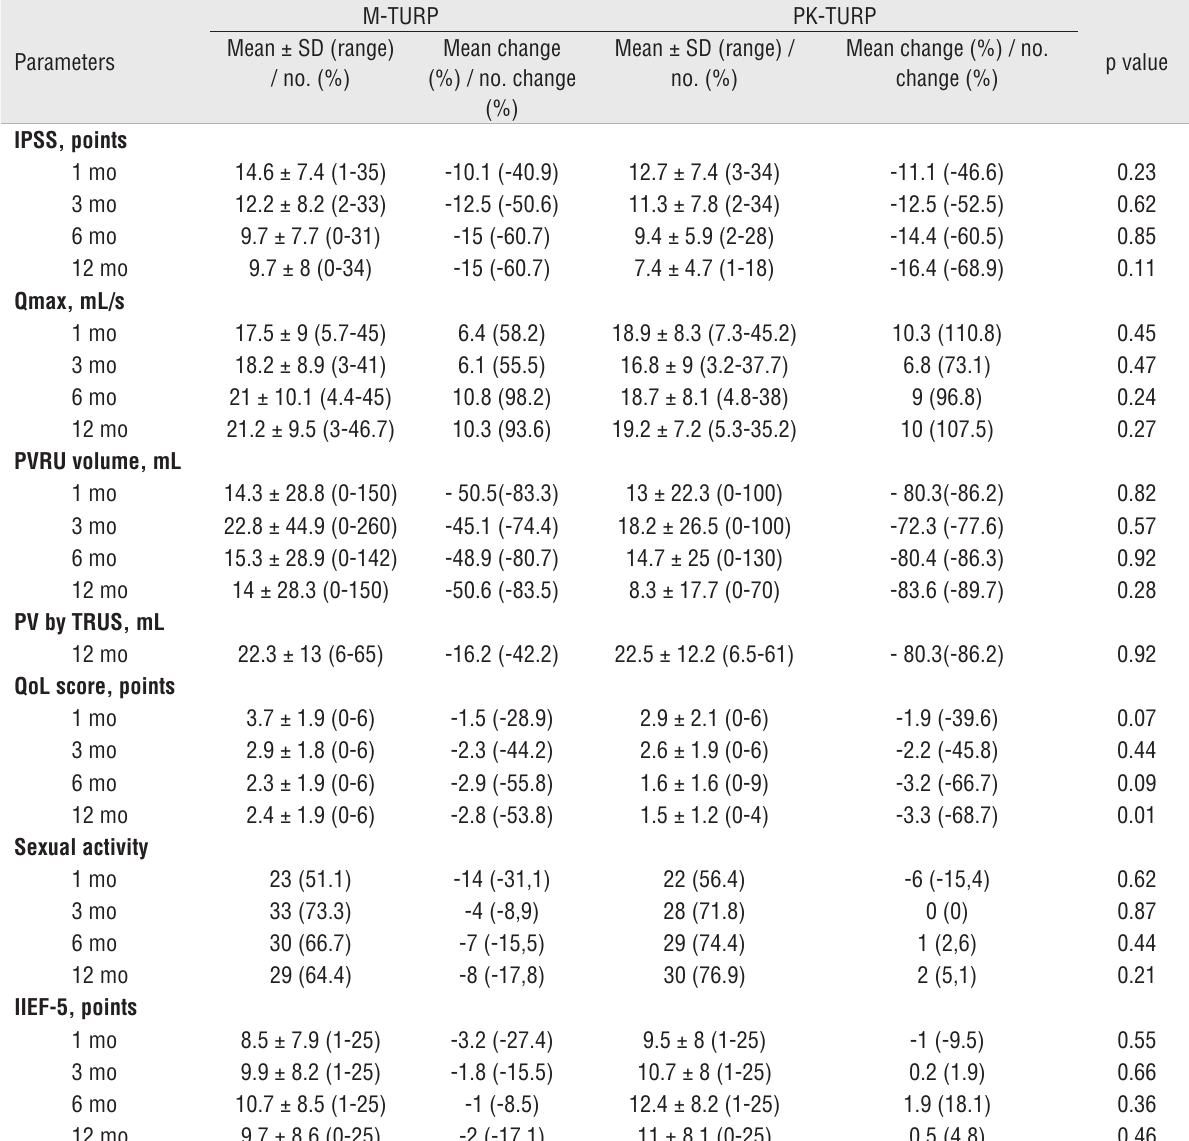
IIEF = International Index of Erectile Function, IPSS = International Prostate Symptom Score, M-TURP = monopolar transurethral resection of the prostate, PK-TURP = plasmakinetic transurethral resection of the prostate, PSA = prostate-specific antigen, PVRU = postvoid residual urine, Qmax = maximum urinary flow rate, QoL = quality of life, SD = standard deviation, TRUS = transrectal